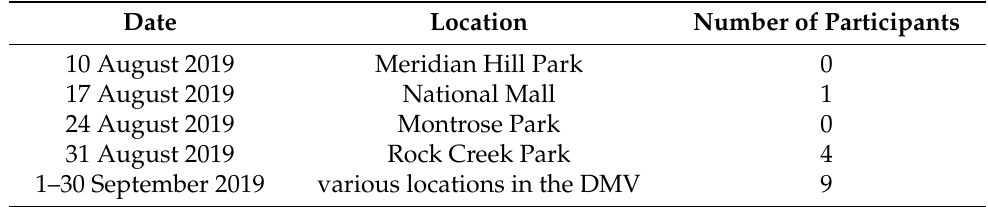
Table 1. Dates, locations, and numbers of participants for first design iteration user